Question: What visual encoding does this figure use to show its data?
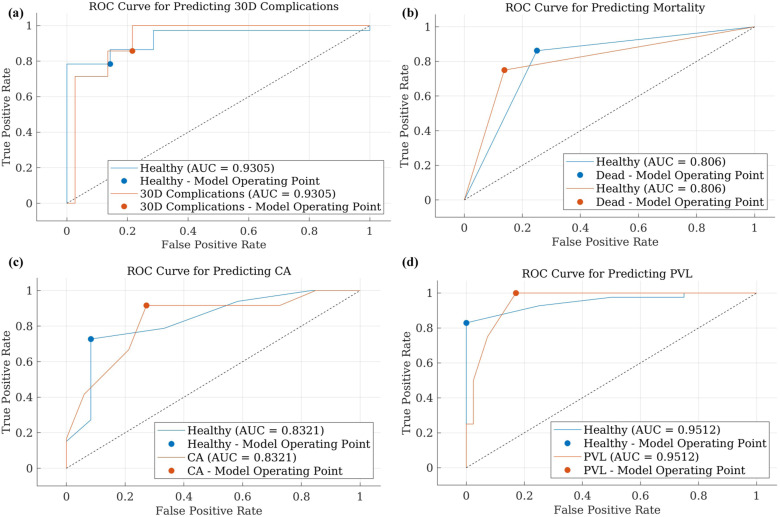
Answer: line